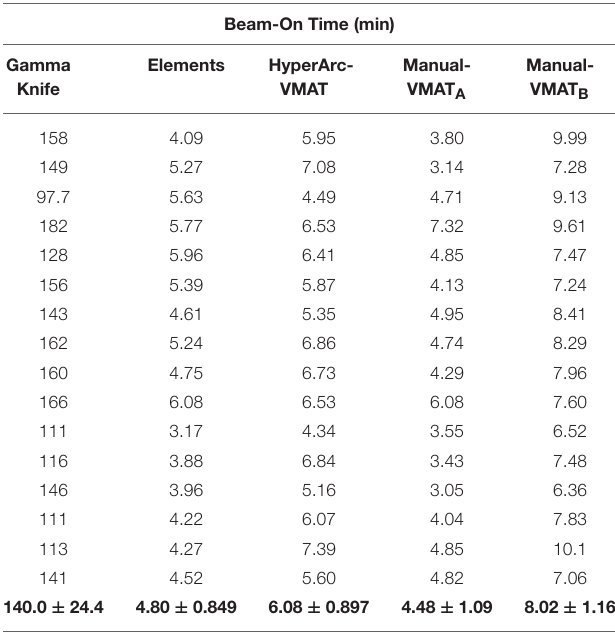
TABLE 3 | Comparison of total beam-on time in minutes per patient SRS plan, assuming a dose rate of 1,400 MU/min for the linac-based options. Beam-On Time (min) Gamma